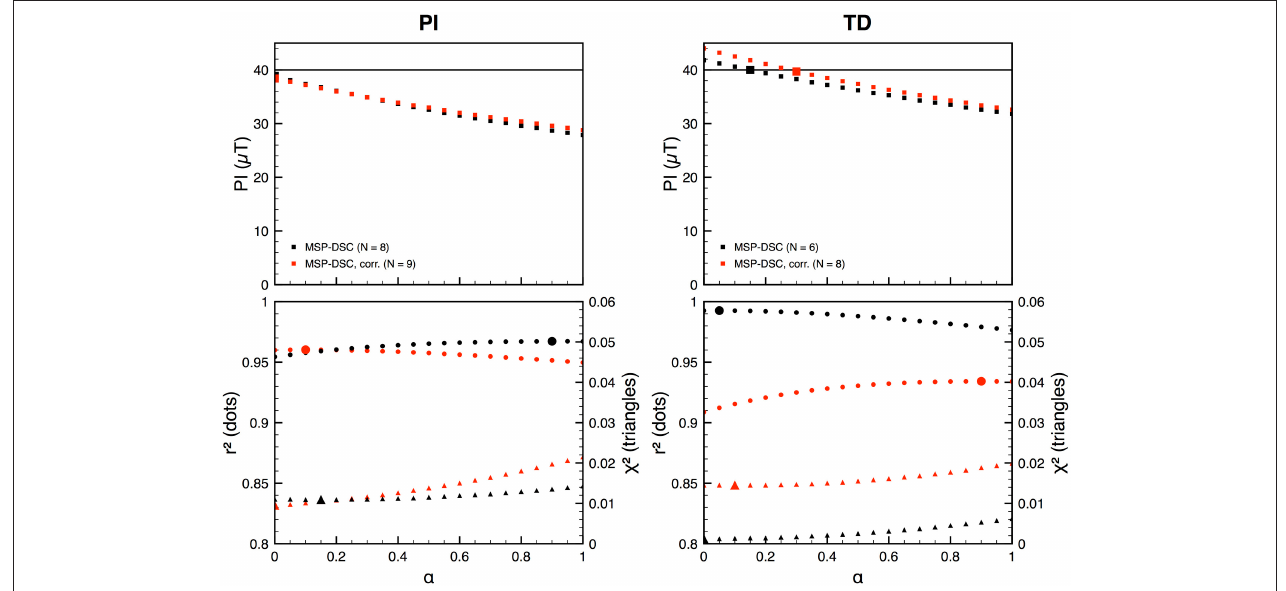
FIGURE 3 | Simulated paleointensity, r 2 , and χ 2 as a function of the α parameter. The optimal values are indicated by larger symbols. r 2 and χ 2 do not change significantly with varying α . The number of samples used in the calculation of the paleointensity N is shown in the legend of the upper figures. For site TD, N increased from 6 to 8 when correcting the data for misalignment; for site PI N increased from 8 to